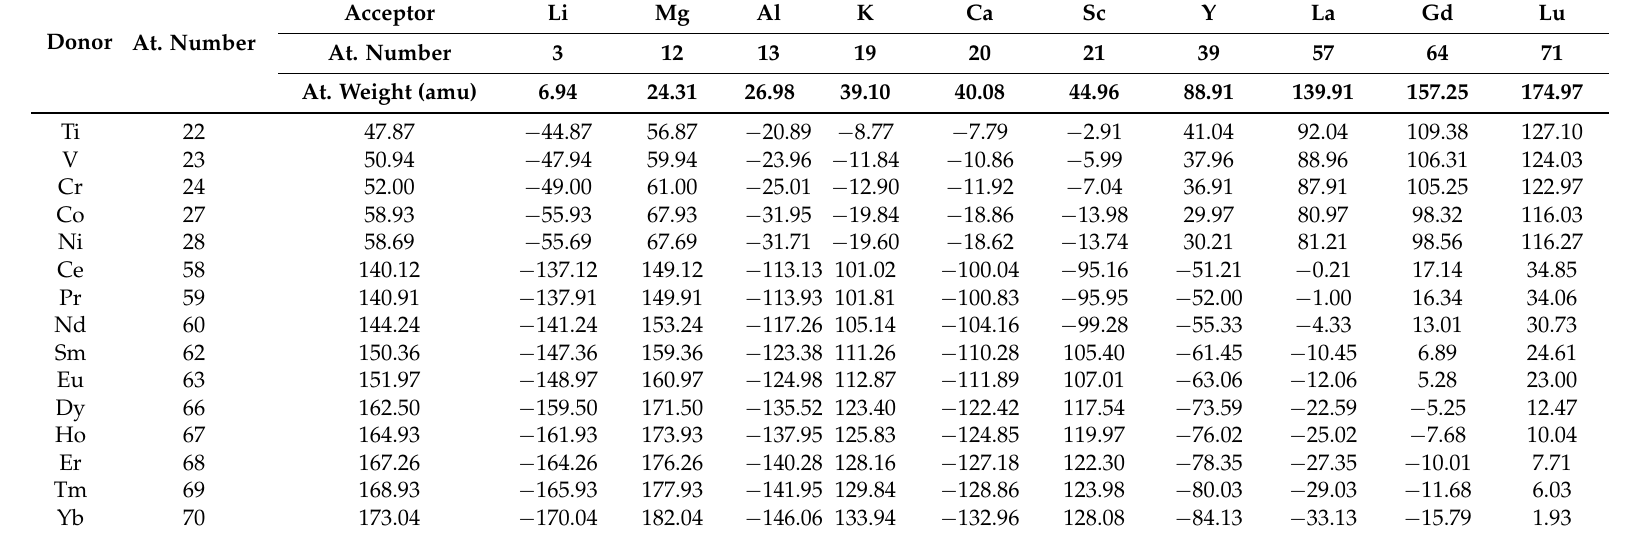
Table 1. Donor-Acceptor atomic numbers, weights, and weight differences for common dopants (donors) and acceptors.